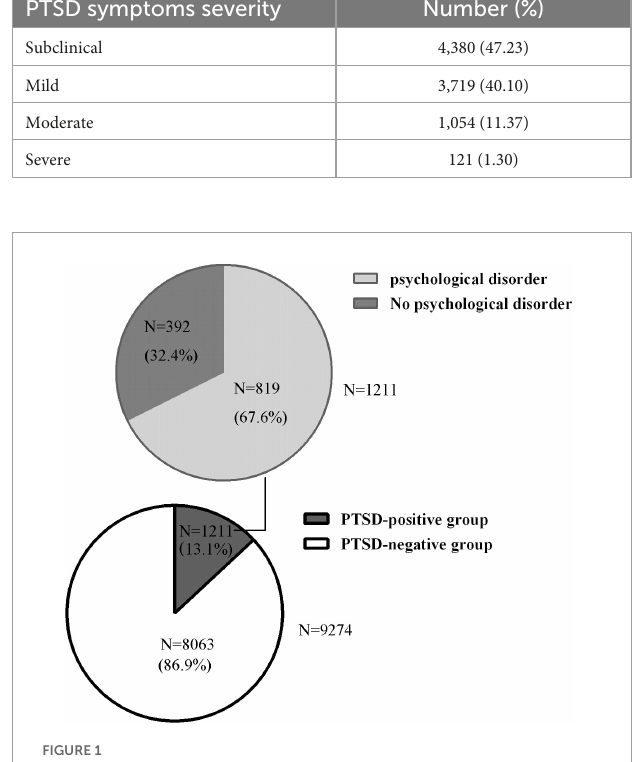
FIGURE1 Percentage of COVID-19-associated PTSD symptoms, anxiety, and depressive symptoms co-existing within the PTSD